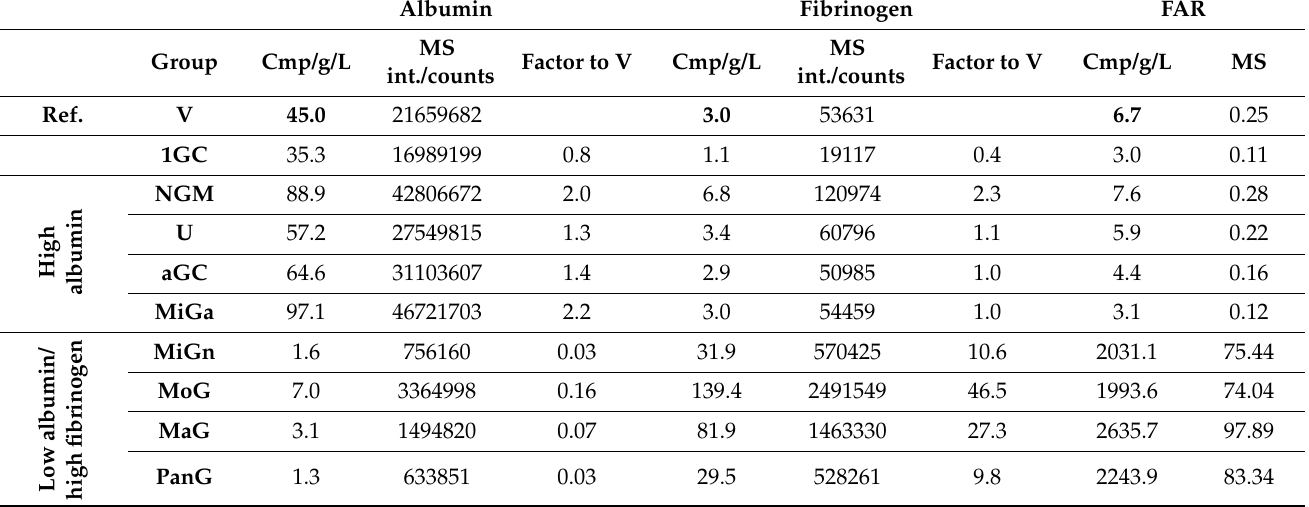
Table 3. Calculation of FAR using average MS intensities (FAR-MS, intensity fibrinogen/intensity albumin). The result was multiplied by 100, as in reference [55]. MS intensities are also set in relation (Cmp) to the reference values for albumin (35–55 g/L) and fibrinogen (2–4 g/L) [51], using an approximate medium value of 45 and 3 g/L, respectively, for the V group, to calculate FAR-Cmp. In order to show the fold change to normal values, the average MS intensities for the respective groups are divided by those seen in V (Factor to V). For details, see Figure 5, Supplementary File